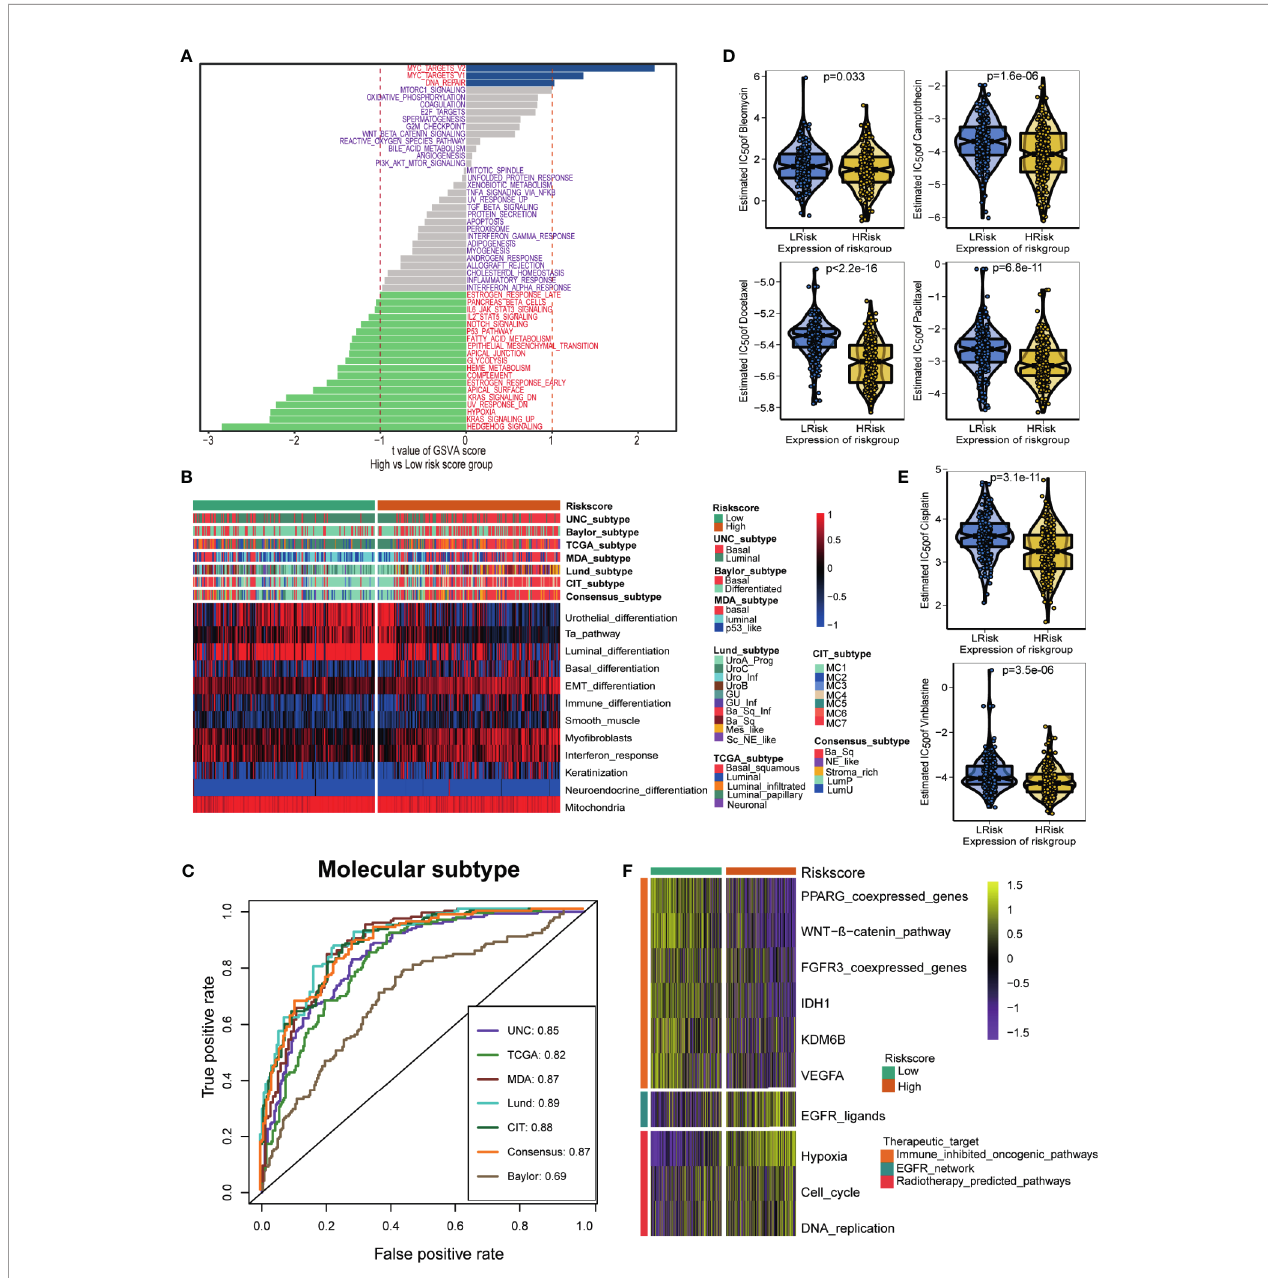
FIGURE 5 | Hypoxia risk score strati fi ed the molecular subtypes and aided in precision medicine. (A) The difference on the hallmark gene sets between hypoxia risk score groups. (B) The associations between the hypoxia risk score groups and the molecular subtypes in seven different algorithms. (C) The predictive accuracy of hypoxia risk score for molecular subtypes in seven different algorithms. (D, E) The difference on the therapeutic sensitivities of six chemotherapy drugs, including Cisplatin, Docetaxel, Paclitaxel, Bleomycin, Camptothecin, and Vinblastine. (F) Correlations between hypoxia risk score and the enrichment scores of several therapeutic signatures such as targeted therapies and